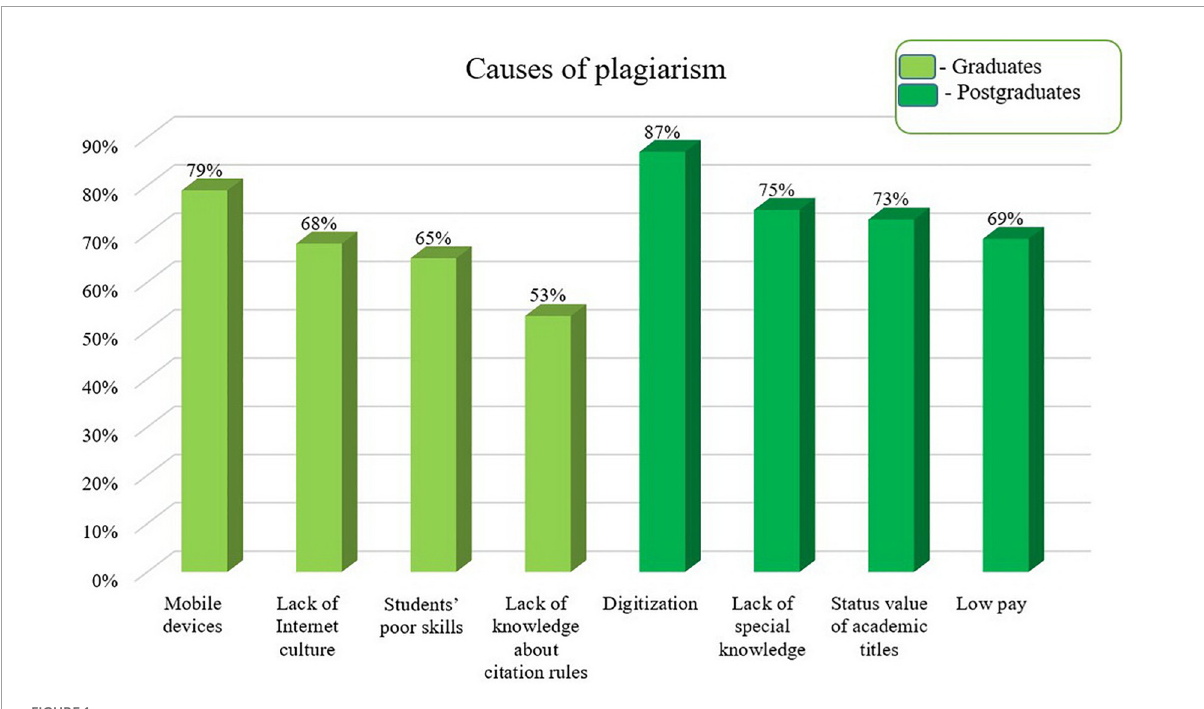
FIGURE1 Reasons for